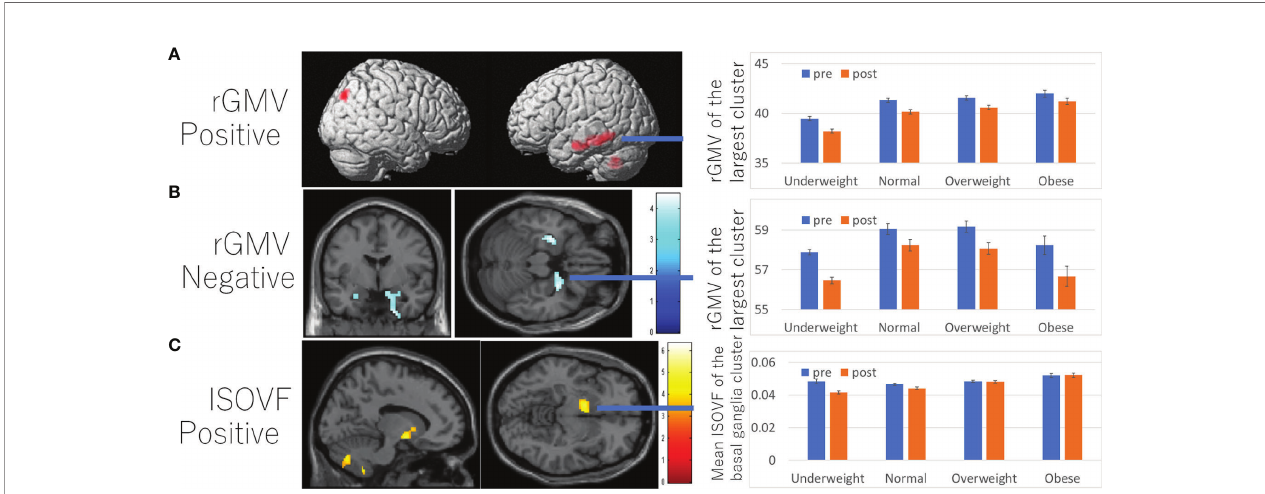
FIGURE 3 | Associations between BMI and subsequent longitudinal changes in brain imaging measures. (A) Positive associations between BMI and rGMV change. (B) Negative associations between and rGMV change. (C) Positive associations between BMI and ISOVF change. (A – C) (left panels) Results are shown with a threshold of P < 0.05 and corrections for multiple comparisons in cluster size tests with a voxel level cluster determining threshold of P < 0.05 (corrected for FDR). (A) Regions with signi fi cant associations were overlaid on a “ render ” image from SPM5. (B, C) The fi ndings were overlaid on a “ single-subject T1 ” SPM5 image. The color represents the strength of the T value. (Right panels) Pro fi les of imaging values at pre and post scans (which correspond to the third and the fourth assessment visits) in the signi fi cant cluster of the left temporal gyrus (A) , right hippocampus (B) , and left basal ganglia areas (C) . For all fi gures, the software used to present the results was selected based on the ease of presenting the intended results. Brain images on which the results were displayed were chosen based on the default availability in the software used and whether the brain images had brain